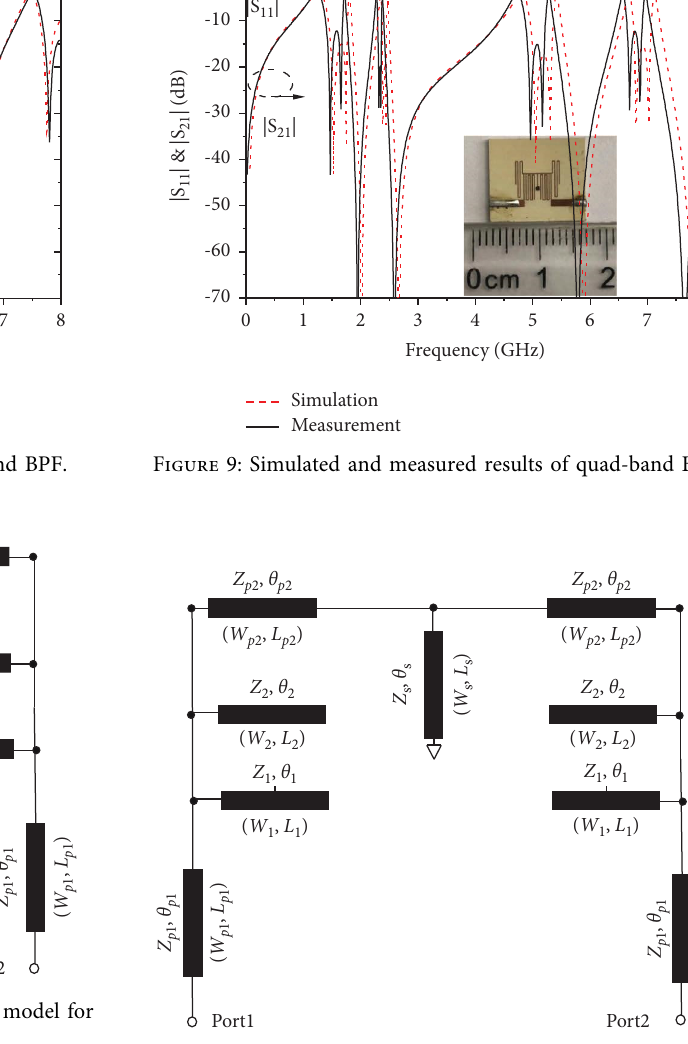
Figure 10: *e quint-band equivalent transmission line model for the proposed